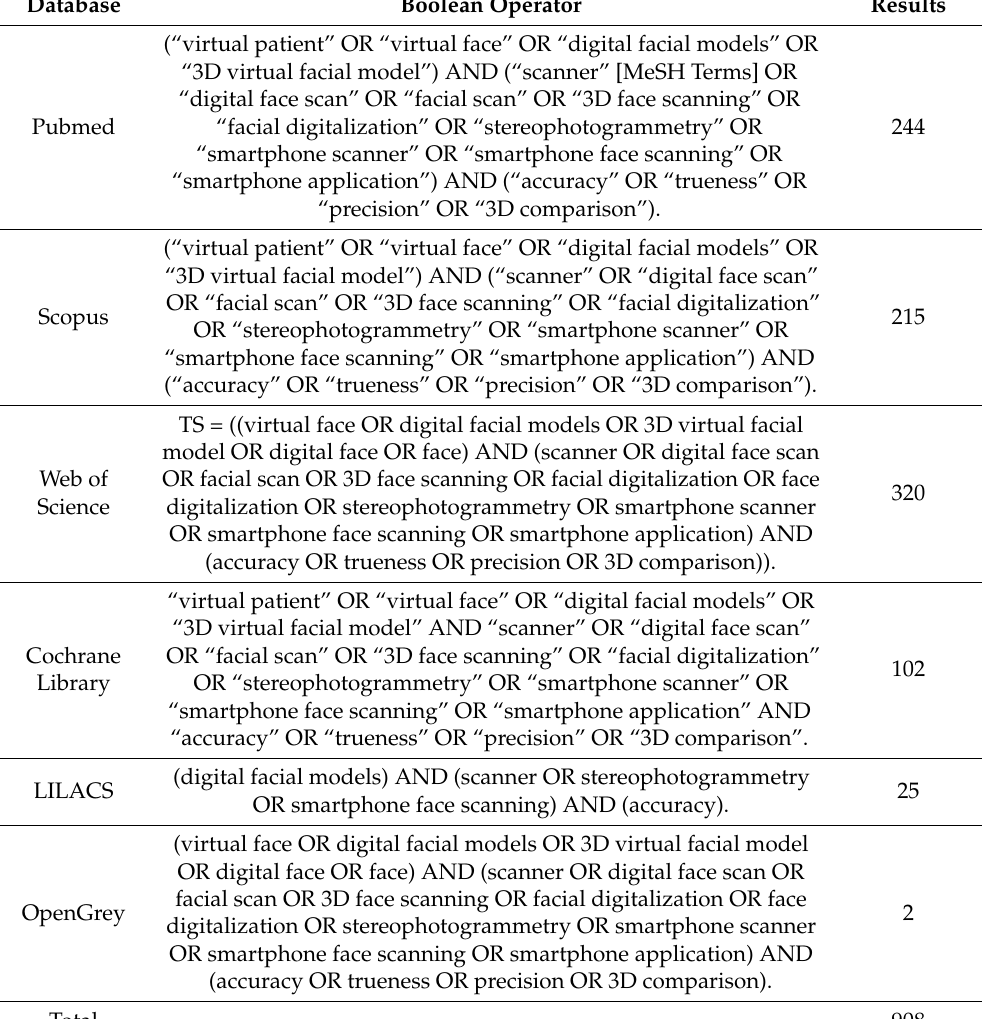
Table 1. Searching strategy in the different